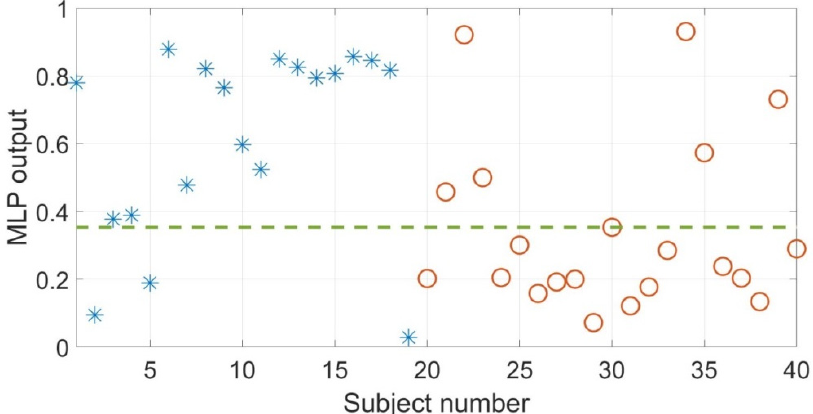
Figure 11. Plot of averaged multilayer perceptron outputs for participants in the test file for inves- tigation B. The stars and circles represent participants with fracture and sprain, respectively. The dashed line is the threshold.